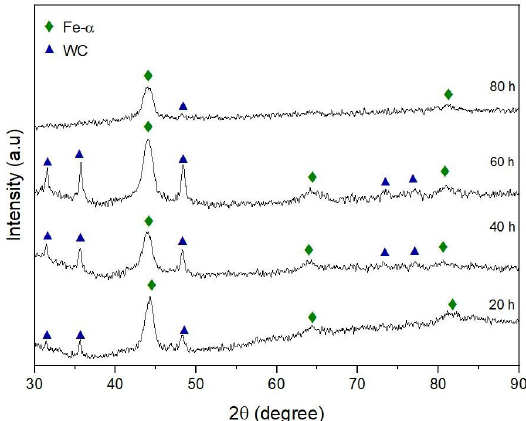
Figure 7. Fe-15at.%Nb sample diffractogram after milling without added